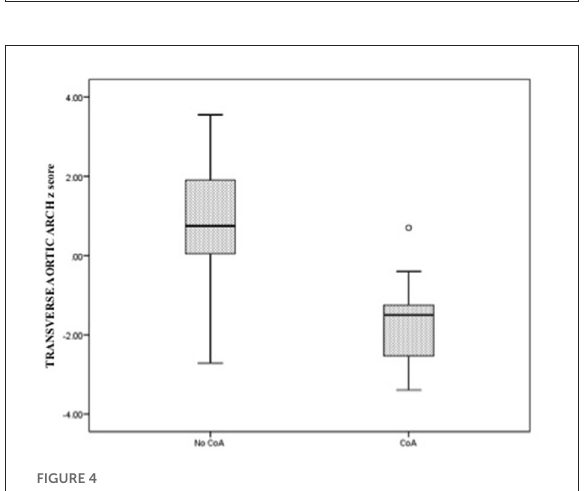
FIGURE4 Box and whisker plots of the z-score, respectively, for aortic valve annulus and the distal transverse aortic arch at the third-trimester echocardiography.